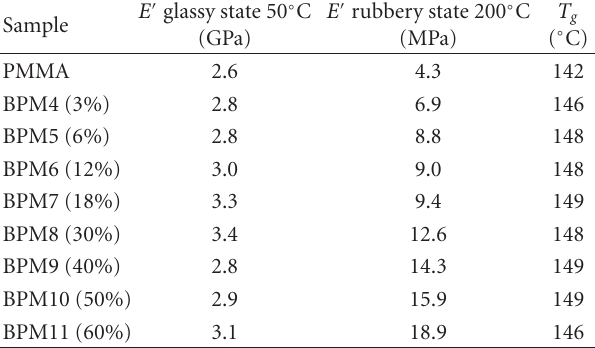
Table 3: Dynamic storage modulus E (cid:3) in the glassy (50 ◦ C) and rubbery (200 ◦ C) state and glass transition temperatures from the maximum in the tan δ